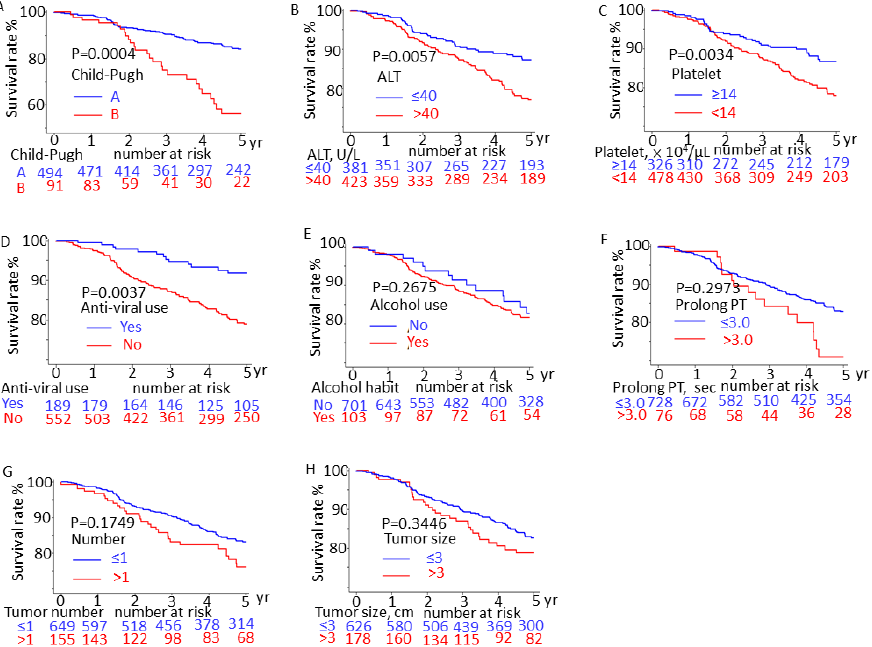
(vs. receiving anti-viral therapy; p = 0.0037; Figure 5D) exhibited significantly lower five- year survival rates.